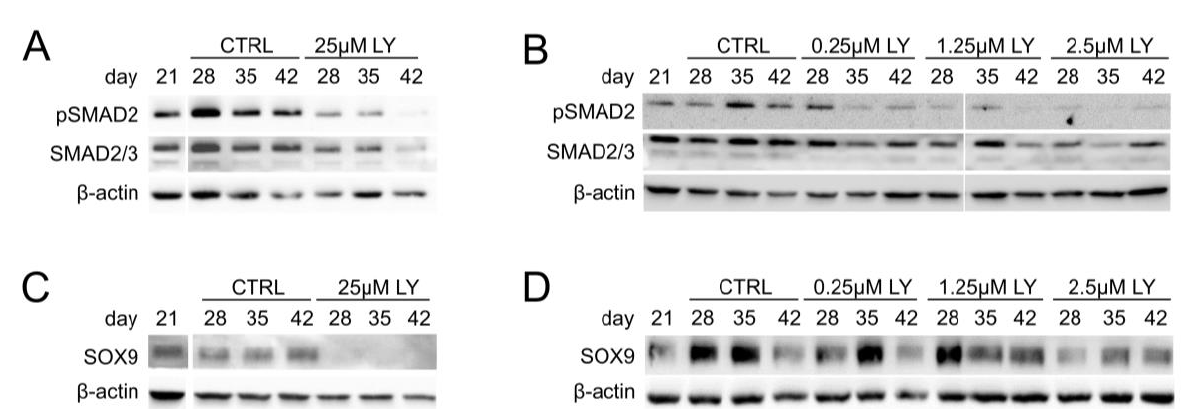
Figure 5. PI3K/AKT signaling is important for TGF β activity and SOX9 protein accumulation. MSC pellets were subjected to chondrogenic culture for 6 weeks and treated with the indicated concentration of LY or DMSO (0.1% for A, C; 0.01% for B, D) from day 21 of chondrogenesis on. Western blot analyses for pSMAD2 and total SMAD2/3 ( A , B ) as well as SOX9 protein ( C , D ) using β -actin as loading control. All samples were loaded on the same gel and detected on the same membrane. Shown is one representative of three independent experiments.